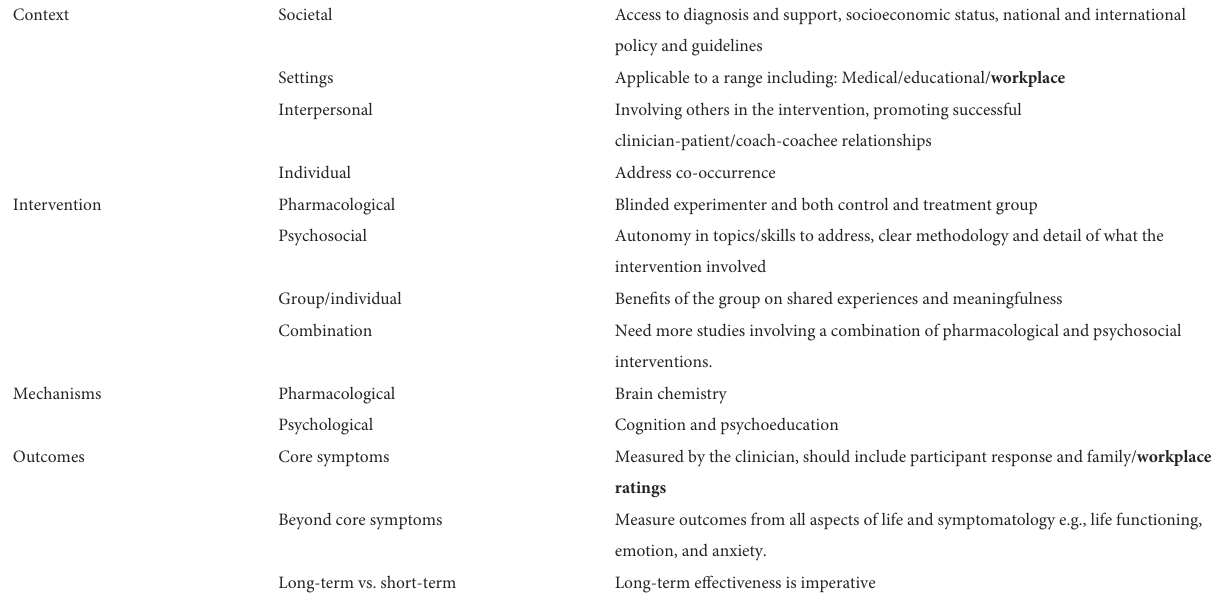
TABLE 8 Findings from the realist evaluation summarized into important